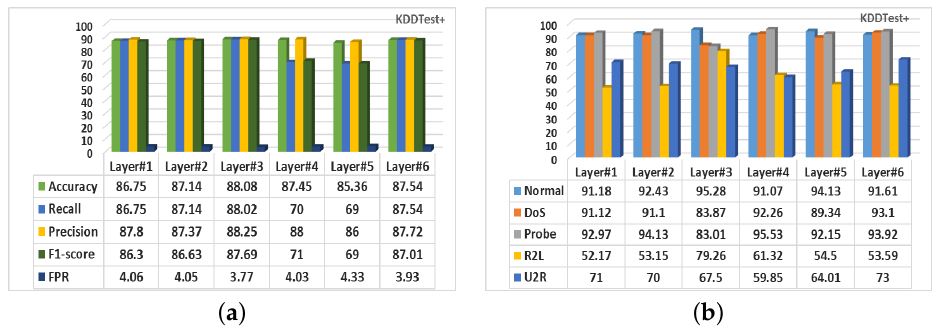
Figure 8. The intrusion detection performance (in %) on different number of hidden layers used in DNN model for KDDTest+ dataset. ( a ) Overall performance; ( b ) Class-wise detection